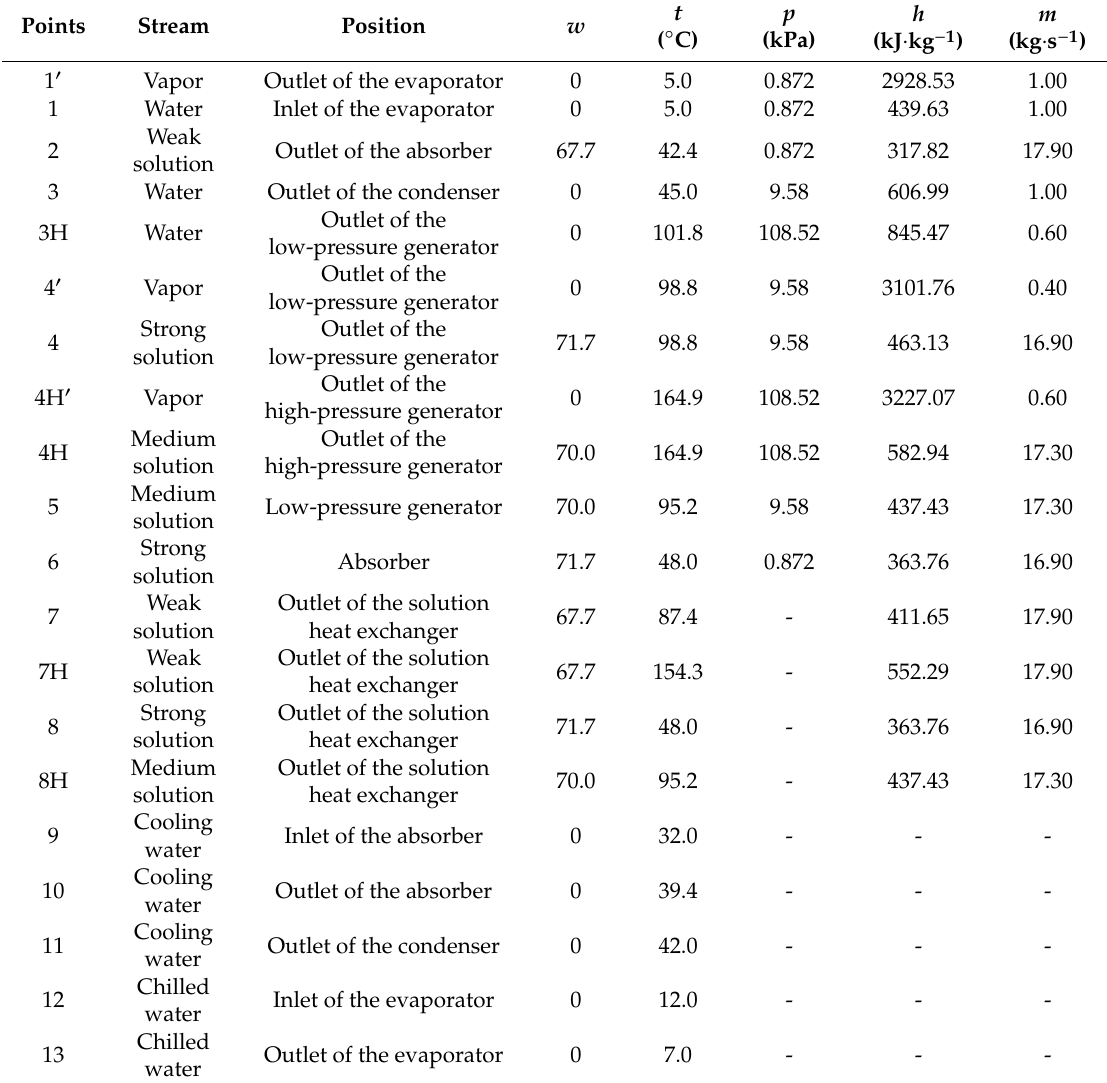
Table 3. State parameters of streams in the cycle with LiBr–[BMIM]Cl(2.5:1) / H 2